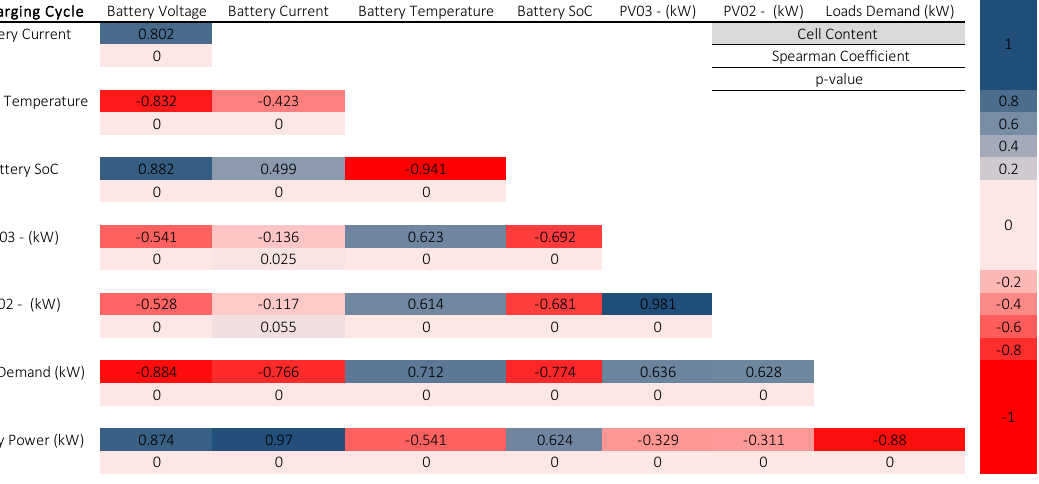
To better assess the relationship between the variables associated with the storage system, as well as their influences, a Spearman’s correlation analysis was developed in Minitab 18 [43], between the storage system voltage, current, temperature, power and state of charge, as well as the demanded load power and the PV-CEAMAZON 02 and 03 systems. Figures 16 and 17 present the correlation matrices between the analyzed varia- bles.